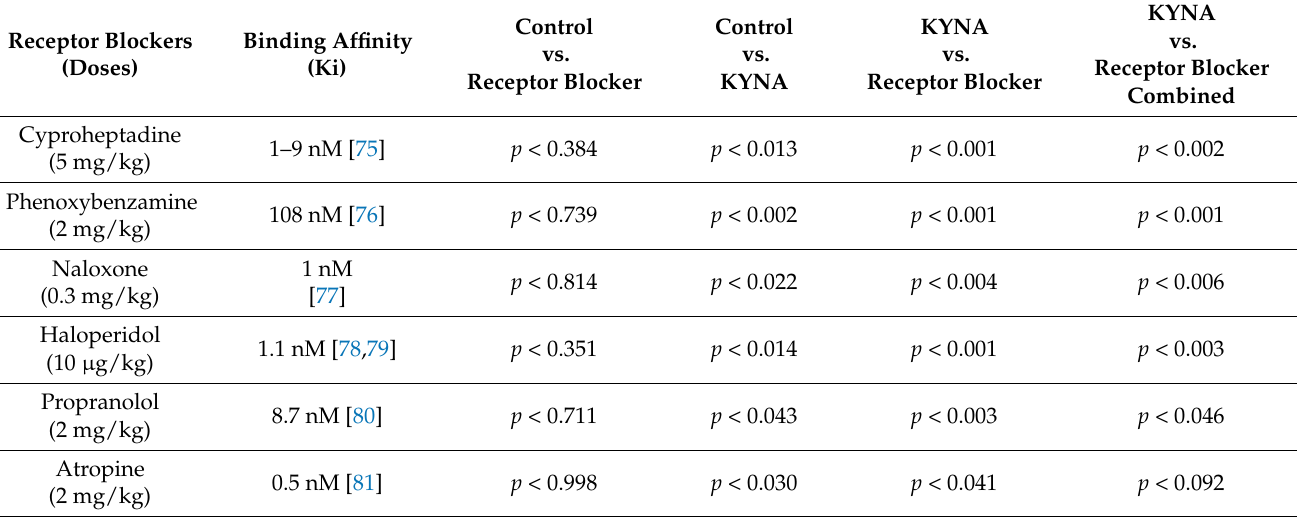
Table 2. The doses and binding affinity of receptor blockers and p